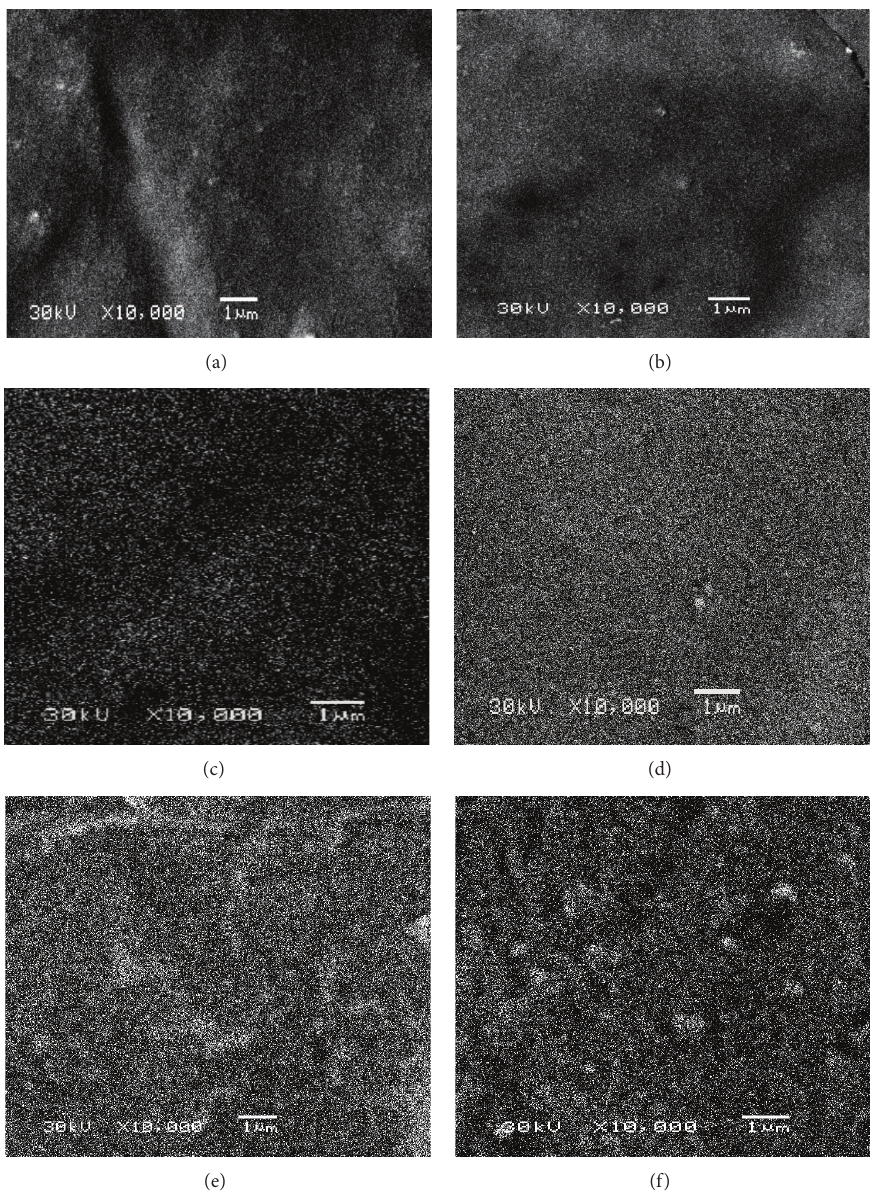
Figure 3: SEM images showing the homogenous dispersion of the nano-SiO 2 ( × 10,000). (a) 0.5% nano-SiO 2 (GII); (b) 1% nano-SiO 2 (GIII); (c) 1.5% nano-SiO 2 (GIV); (d) 2% nano-SiO 2 (GV); (e) 2.5% nano-SiO 2 (GVI); (f) 3% nano-SiO 2